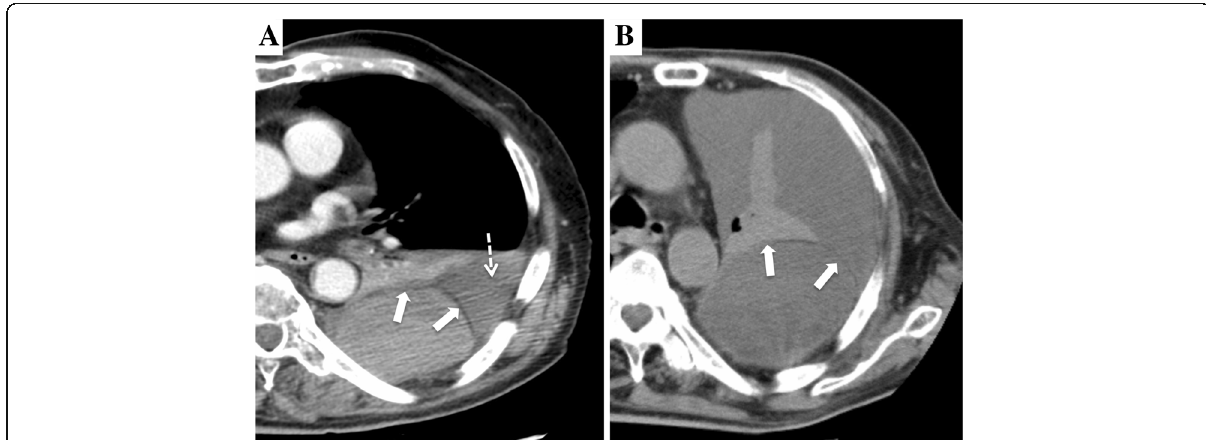
Fig. 2 Chest computed tomography showing hemothorax (dashed arrow), a convex extrapleural hematoma with extrapleural fat sign (white arrow), and atelectasis of the left lower lobe on the patient ’ s posterior chest wall on admission ( a ) and a large amount of pleural effusion and atelectasis with a residual extrapleural hematoma (white arrow) 53 days after the episode of trauma ( b